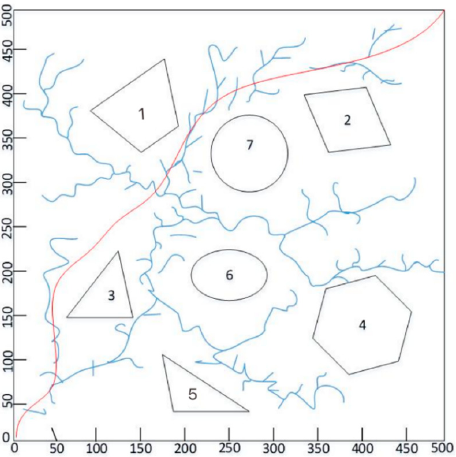
Figure 13. Result of path planning based on the AV-RRT algorithm.